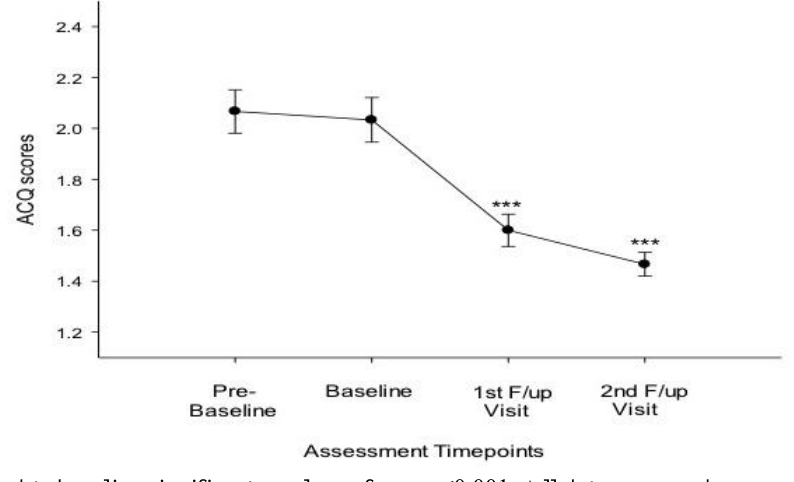
Figure 2. Asthma control questionnaire (ACQ) score at the four timepoints of assessment for all 18 patients.